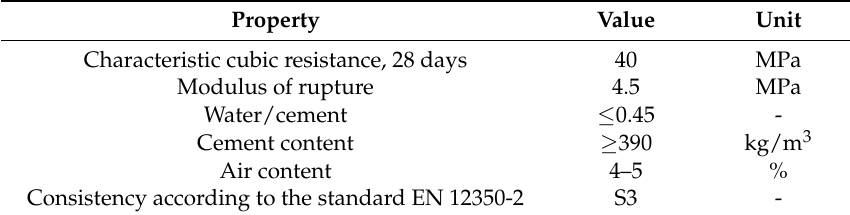
Table 7. Physic and mechanical minimum properties of concrete.